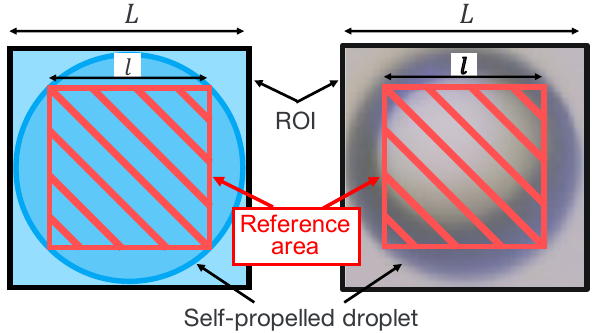
Figure 5. Reference area for color information